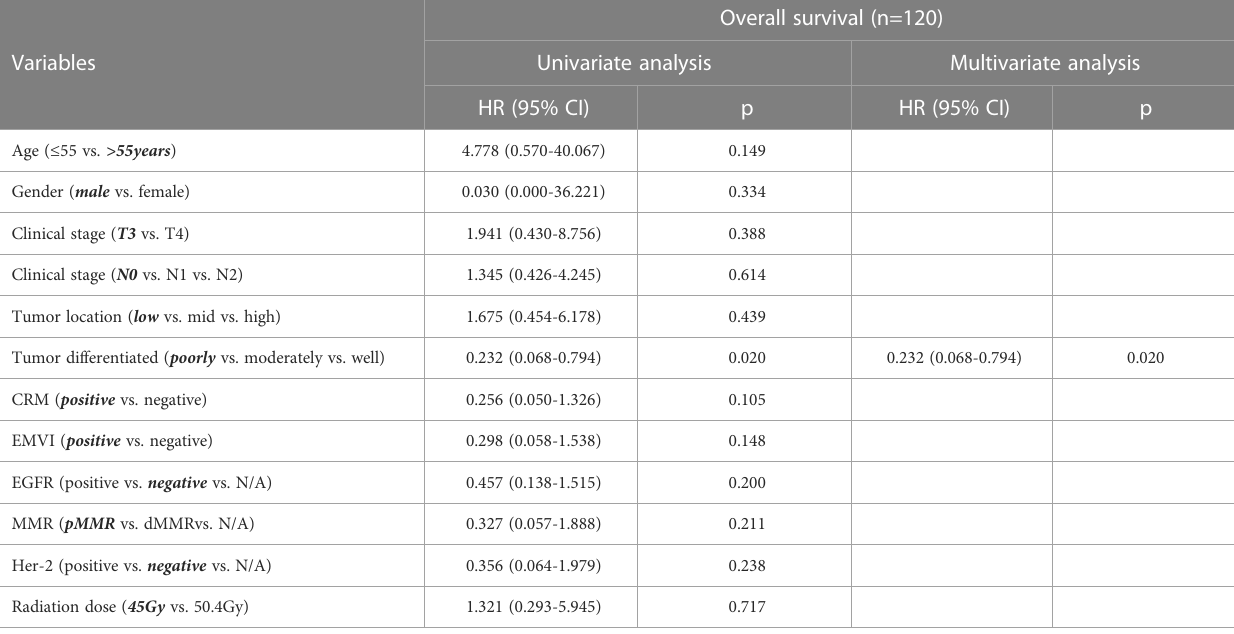
TABLE 5 Univariate and multivariate Cox regression analyses for different variables and OS in LARC patients.